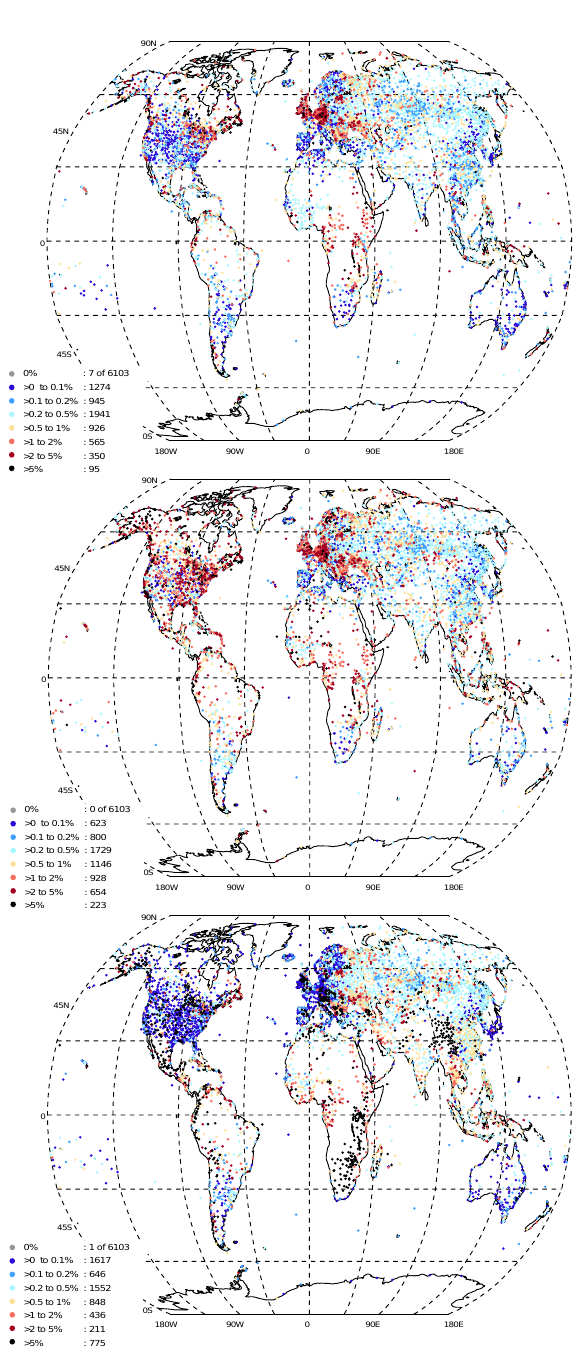
Fig. 20. Rejection rates by variable for each station. Top panel: tem- perature, Middle panel: dewpoint temperature, and Lower Panel: sea-level pressure. Different rejection rates are shown by different colours, and the key in each panel provides the total number of sta- tions in each band.